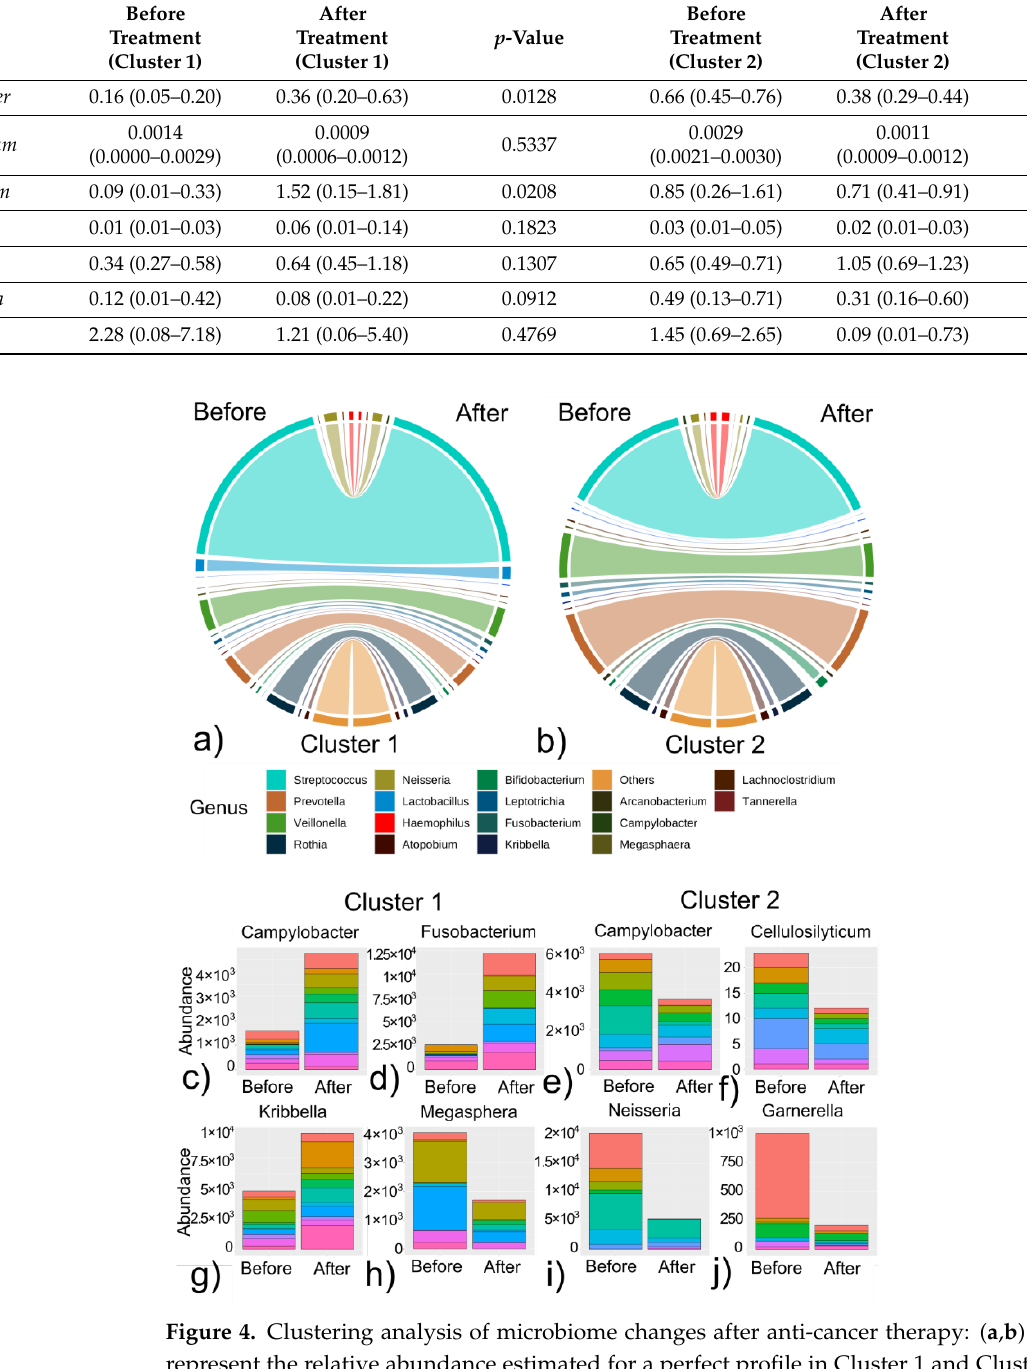
Table 3. Genera abundance summary after unsupervised classification (using k-means), based on patient-specific relative abundances (before and after anticancer therapy). Campylobacter , Fusobacterium , and Neisseria demonstrate a difference in abundance before and after therapy in at least one of the predefined groups. Change in abundance is compared using Wilcoxon signed-rank test, p < 0.15 is defined as significant.